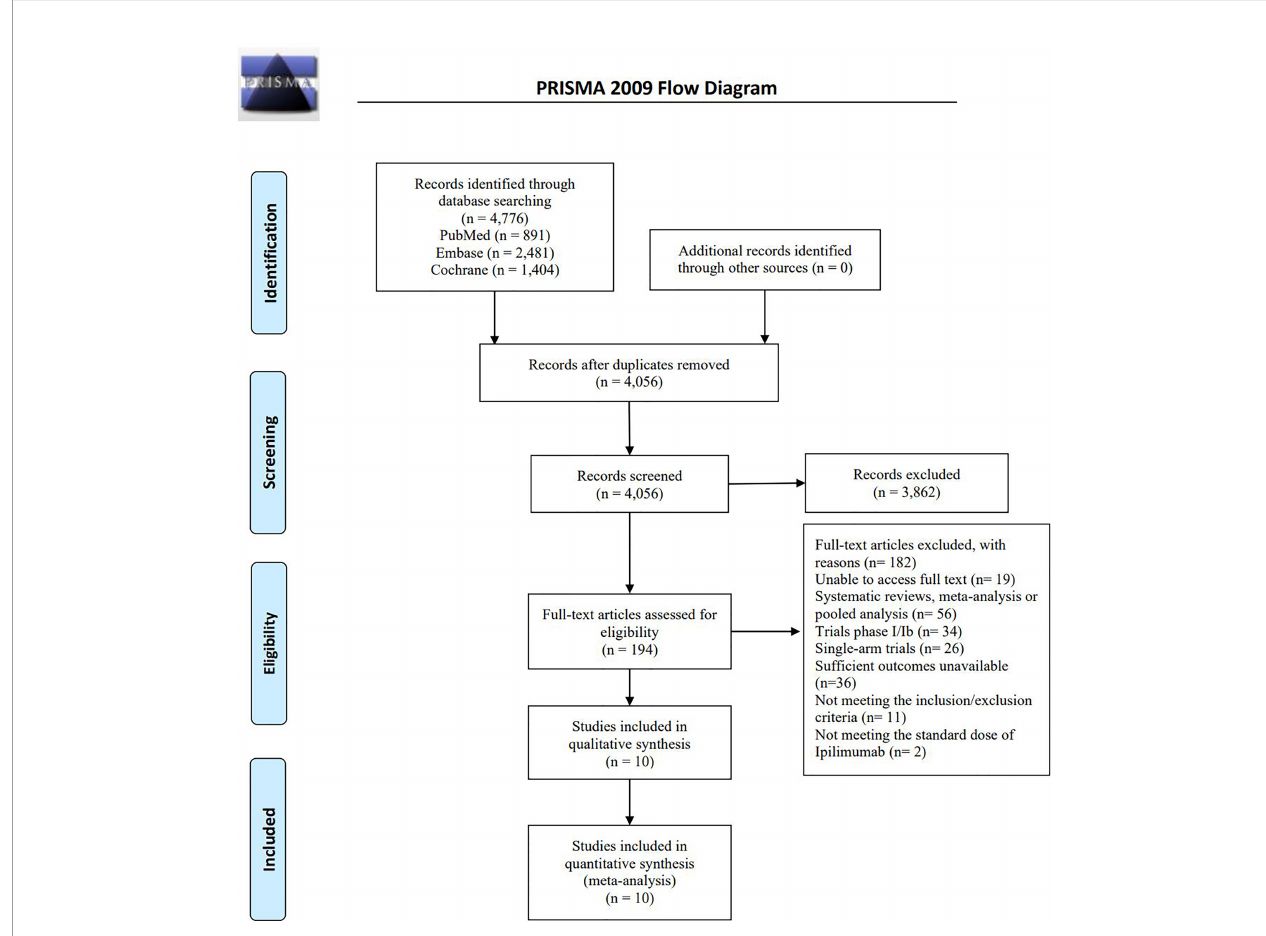
FIGURE 1 | Flowchart of study search and